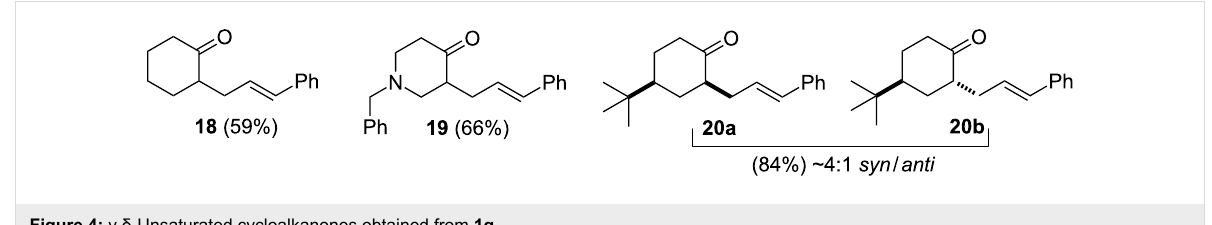
Figure 4: γ , δ -Unsaturated cycloalkanones obtained from 1g .